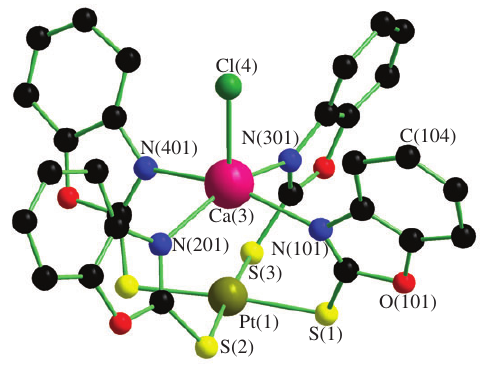
Figure 10 Structure of [Pt ( μ -mbo)